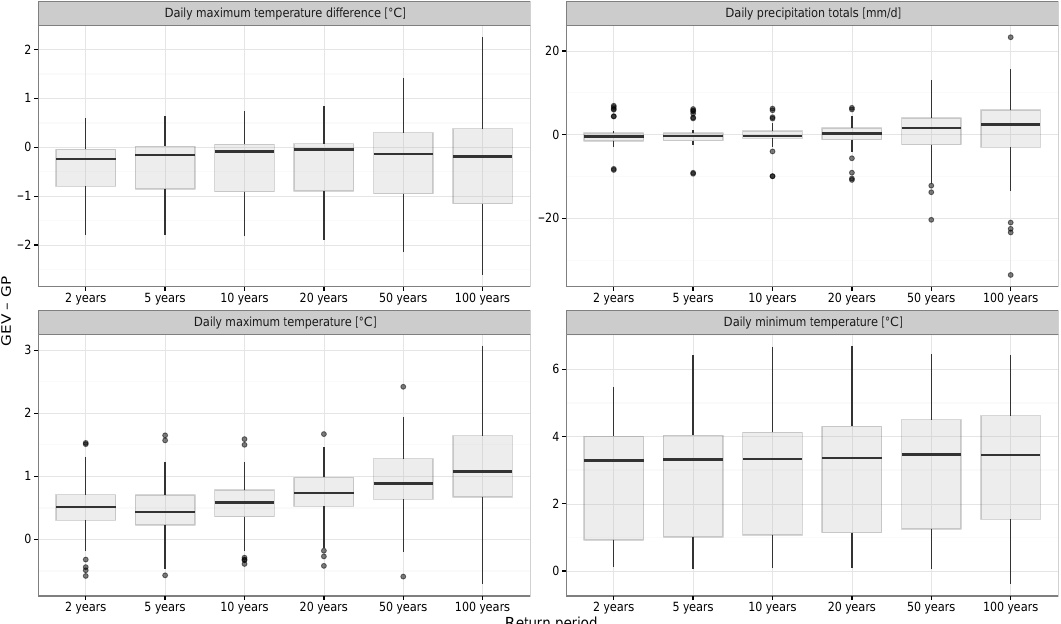
Figure 5. Differences in estimated return levels between GEV and GP models for six selected return periods. These differences are calculated by subtracting the GP estimate from the GEV estimate, given the same parameter estimation method. This results in n = 50 observations per box